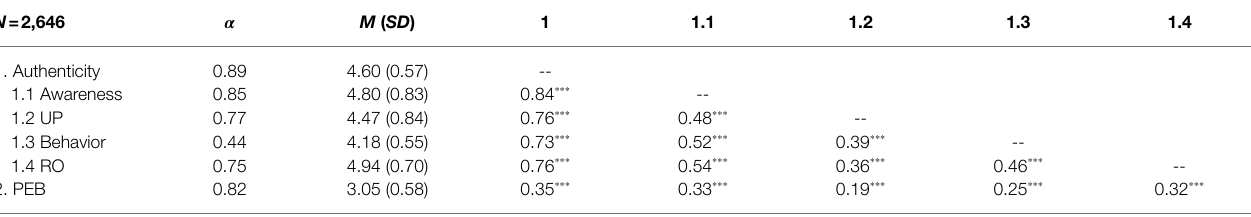
TABLE 1 | Descriptive and correlational statistics in Study 1. N =